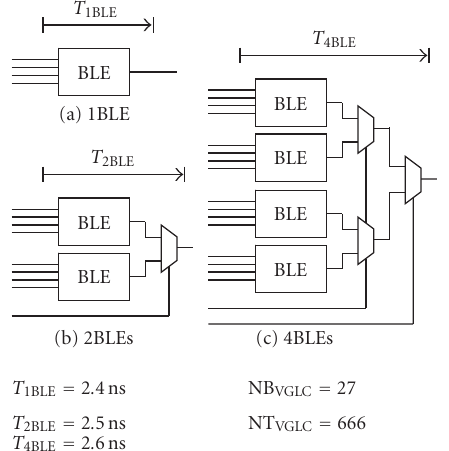
Figure 12: Three components of the